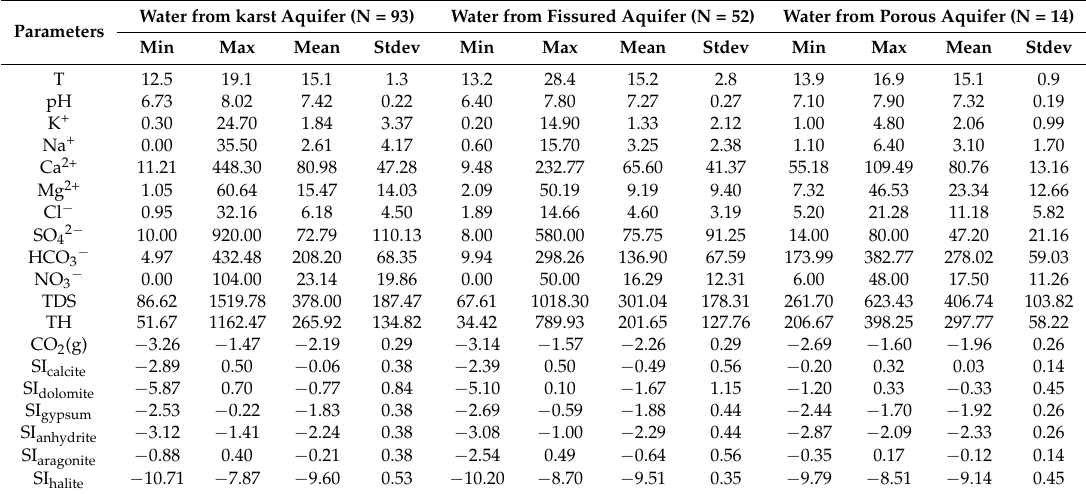
Table 1. Statistical analysis of the physicochemical parameters of groundwater samples from different aquifers.